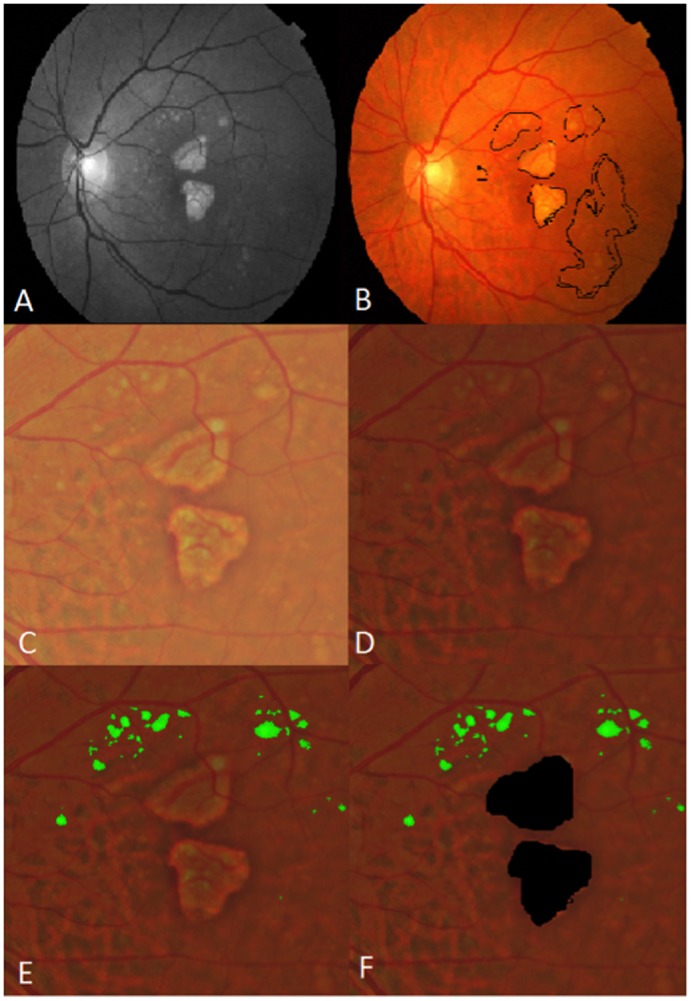
Segmentation of drusen and geographic atrophy (GA).A) Original red-free fundus photograph B) Original color fundus photograph with areas of drusen and GA outlined (black) C) Color fundus photograph cropped to 6 mm field. D) contrast enhanced color photo. E) segmentation of drusen (green) within the 6 mm field F) areas of GA masked (black).